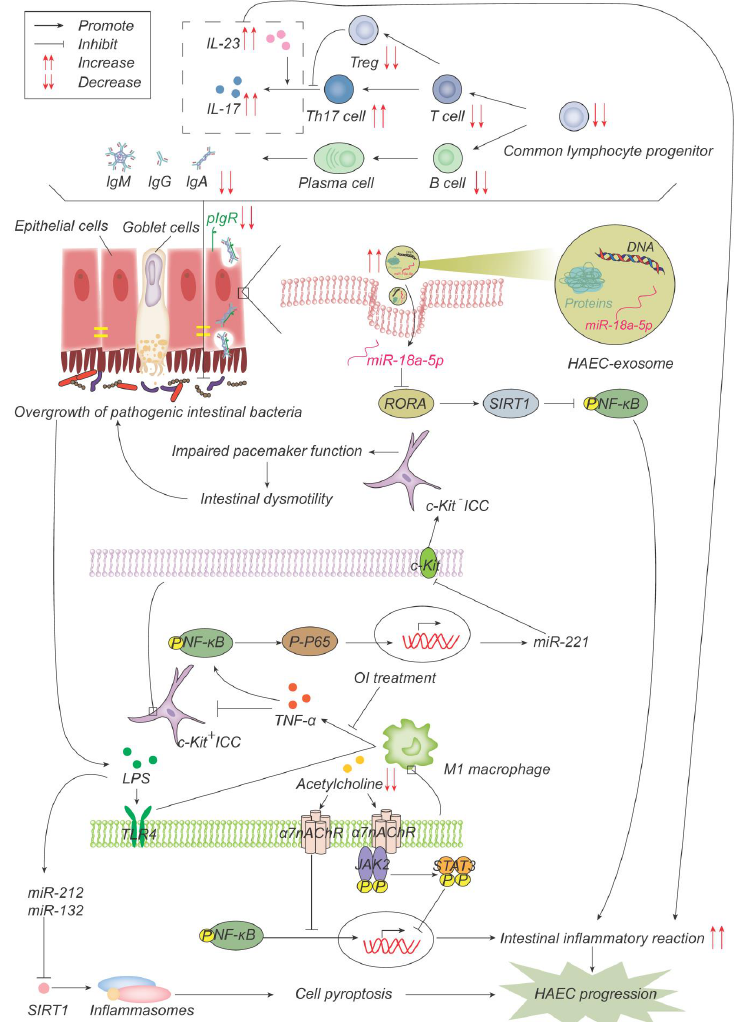
Figure 4. Pathogenesis advances in immunity. The number of common lymphocyte progenitor popu- lations and, therefore, T cells and B cells decrease significantly, resulting in reduced immunoglobulin, which is actively transported to the mucosal surface by polymerized immunoglobulin receptors (pIgR) in the form of dimers to maintain the intestinal microenvironment balance and normal function. pIgR is also reduced, which together leads to intestinal microenvironment disturbances and bacterial overgrowth. Increased Th17 cells produce more IL-17 and promote the intestinal inflammatory response. On one hand, LPS produced by bacteria activates M1 macrophages through the TLR4 pathway, and M1 macrophages produce TNF- α , which inhibits c-Kit expression in ICC through the NF- κ B/miR-221 pathway, leading to intestinal motility disorders, which further leads to the accumulation and overgrowth of intestinal bacteria. 4-octyl itaconate (OI) reduces the production of proinflammatory factors and promotes ICC phenotypic recovery by inhibiting macrophage activation. LPS, on the other hand, induces the up-regulation of miR-132/-212, activates inflammasome NOD-, LRR-, and pyrin domain-containing protein 3 (NLRP3) by inhibiting the expression of sirtuin 1 (Sirt1), promotes cell pyroptosis, and then promotes the occurrence and development of HAEC. Acetylcholine acts on α 7 nicotinic acetylcholine receptor ( α 7nAChR) on the surface of macrophages, inhibits the activation of macrophages, activates the anti-inflammatory pathway of JAK2-STAT3 and suppresses the inflammatory pathway of NF- κ B. Acetylcholine in HAEC is reduced, and the above anti-inflammatory effects are weakened. Exosome miR-18a-5p down-regulates RAR-related orphan receptor A (RORA), activates the SIRT1/NF- κ B signaling pathway, induces excessive inflammatory response, and thus promotes the development of